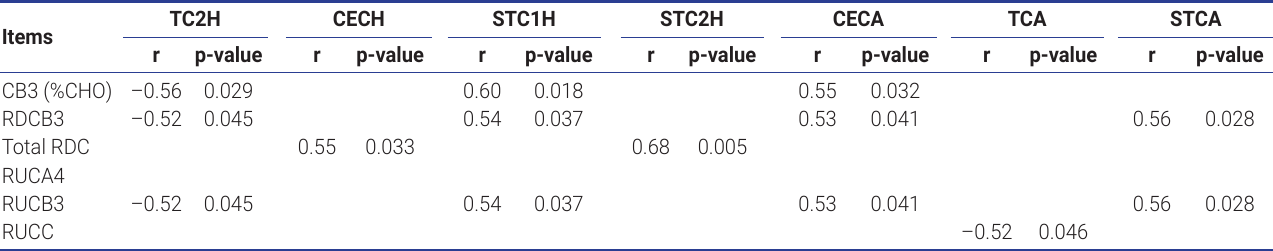
Table 3. Correlation between FTIR carbohydrate structures and the carbohydrate portions of the CNCPS system of canola meals